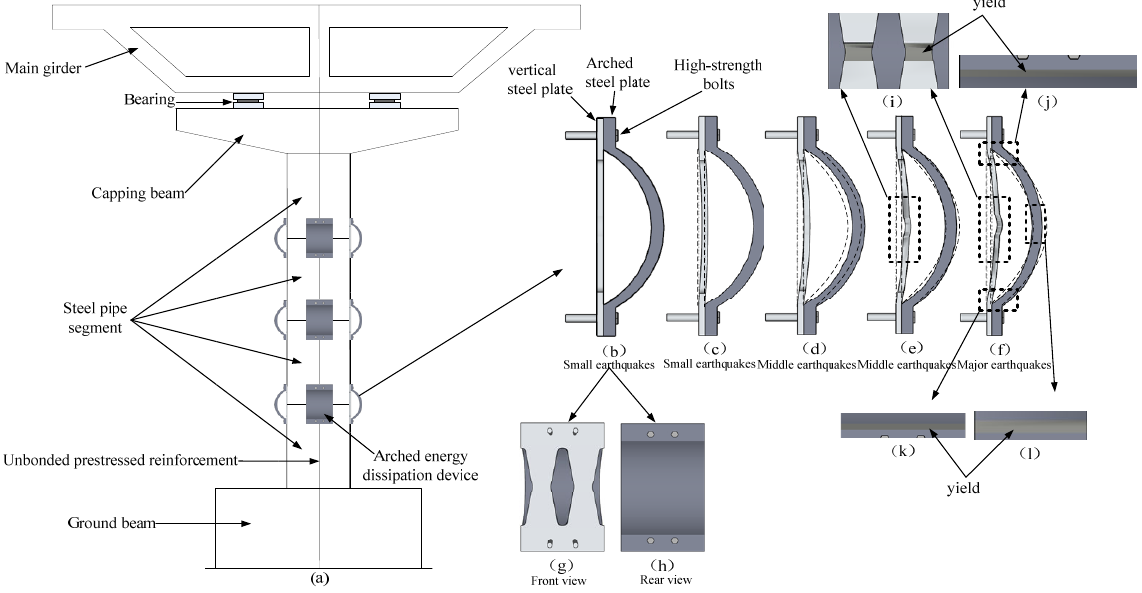
Figure 2. Schematic diagram of the force and failure process of the arched energy ‐ consuming device.